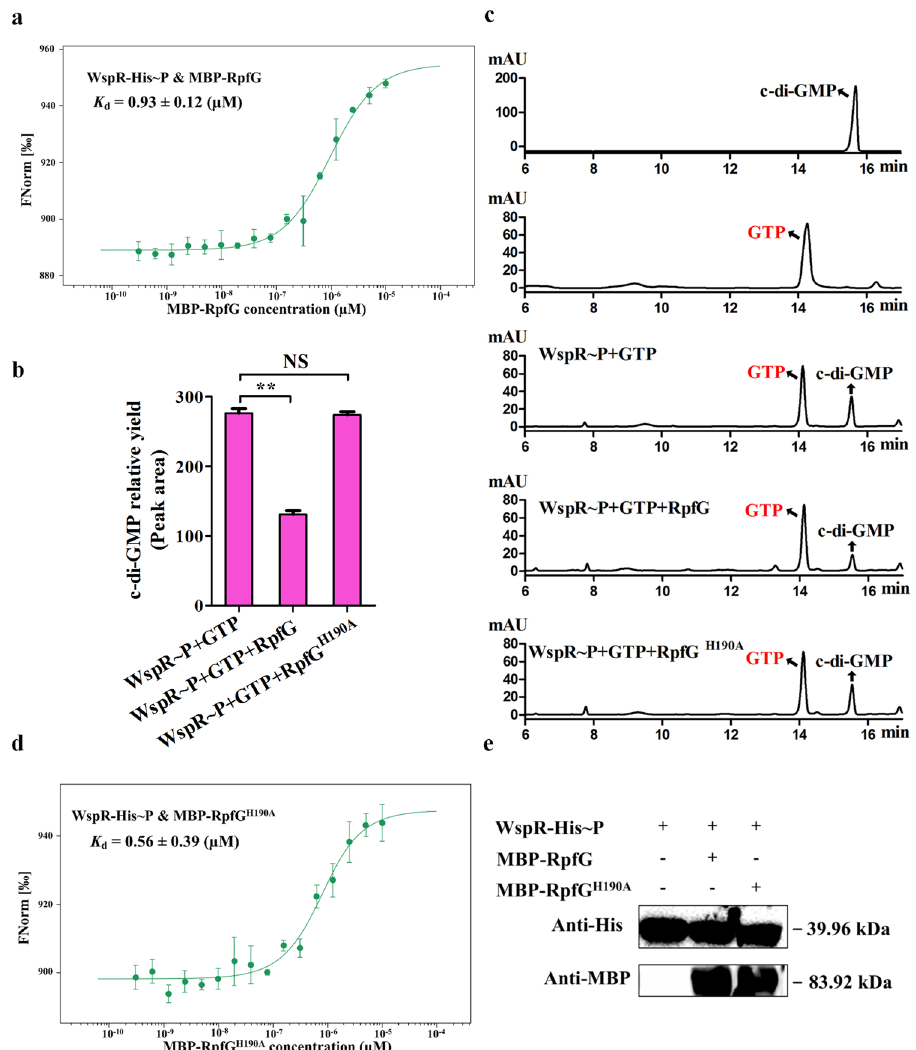
Fig. 6 Phosphorylation of WspR decreases its binding af fi nity to RpfG and blocks the capacity of RpfG to function as an adaptor protein. a MST showing that phosphorylated WspR (WspR-His~P) interacts with MBP-RpfG with moderate af fi nity ( K d , 0.93 μ M). b Phosphorylation of WspR (WspR~P) reduces c-di-GMP synthesis in the presence of MBP-RpfG using GTP as a substrate but not MBP-RpfG H190A . The peak area of the HPLC chromatogram is expressed as the relative yield of c-di-GMP (y-axis). MBP-RpfG H190A represents an enzymatically inactive variant of MBP-RpfG. c HPLC chromatogram corresponding to b . The c-di-GMP and GTP standard are represented in black and red, respectively. d MST showing that WspR-His~P interacts with MBP-RpfG H190A with moderate af fi nity ( K d , 0.56 μ M). e Western blotting showing that the reaction system in b did not affect the stability of the tested protein. Anti-MBP and anti-His antibodies were used to detect WspR~P (39.96 kDa), RpfG, or RpfG H190A (83.92 kDa). All blots derive from the same experiment and that they were processed in parallel. Statistical comparisons were performed using one-way ANOVA of GraphPad software (GraphPad, La Jolla, CA). In panels b , mean data ± SD from three experiments were shown, ** P < 0.01. NS means not signi fi